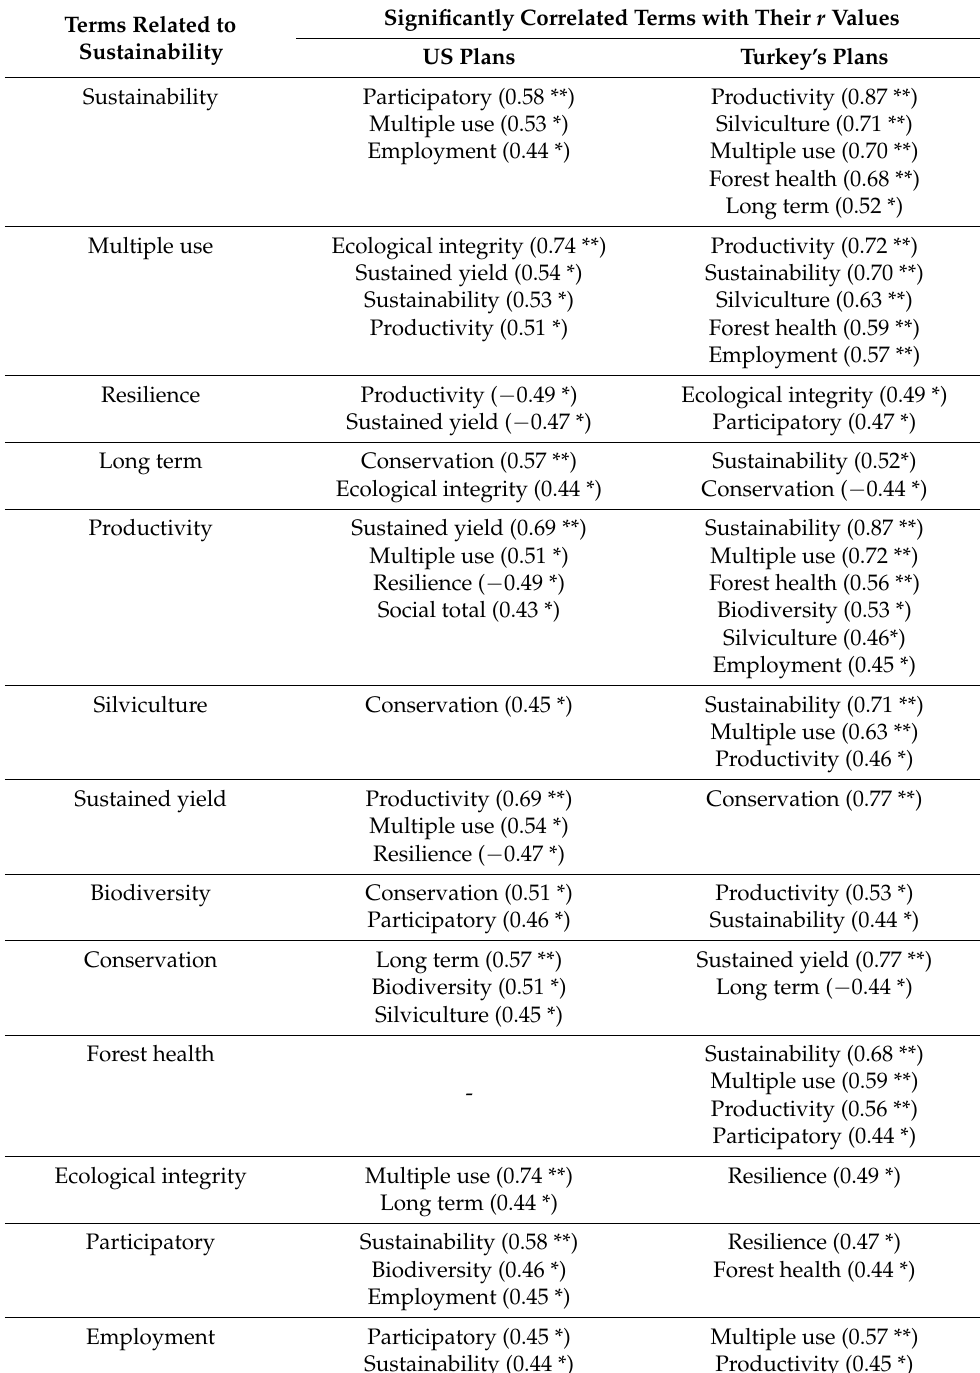
Table 6. The correlative relationships among the terms related to forest